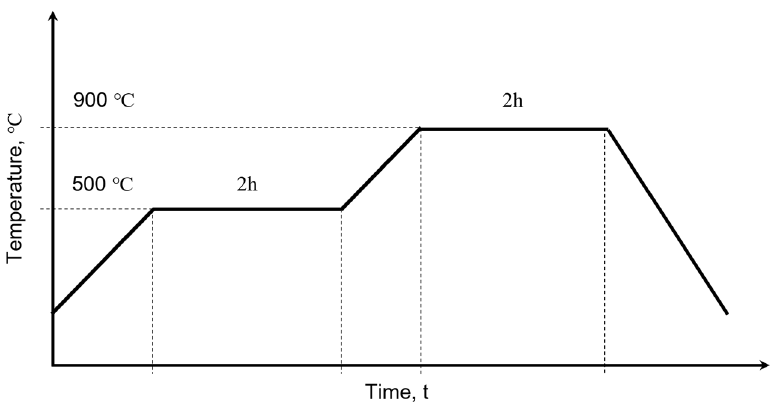
Figure 1. Two-step sintering profile.